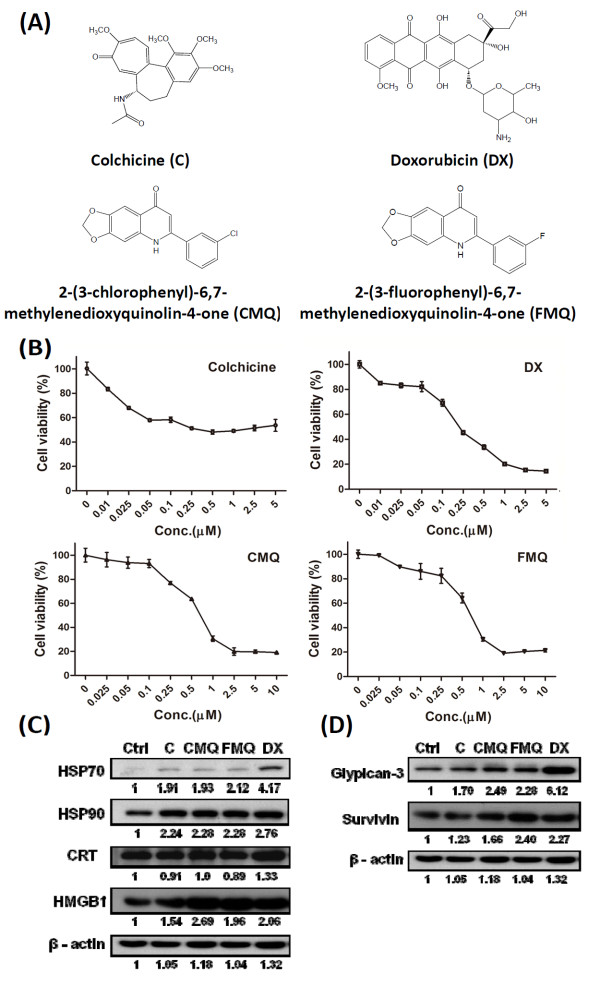
Expression of damage-associated molecular patterns (DAMPs) and tumor-associated antigens in tumor cell lysates of treated B16 melanoma. (A) The chemical structures of microtubule-depolymerizing agents and doxorubicin tested in this study are shown in A. (B) Effect of MDAs and doxorubicin on cell viability of B16 melanoma cells. Mouse B16 melanoma cells were treated with the indicated concentrations of colchicine, doxorubicin (DX), 2-(3-chlorophenyl)-6,7-methylenedioxyquinolin-4-one (CMQ) and 2-(3-fluorophenyl)-6,7-methylenedioxyquinolin-4-one (FMQ) for 24 h, as shown in B. The values are represented as the percentage of viable cells; the vehicle control group was regarded as 100% viable. Cell viability was determined by MTT assay and data were expressed as mean ± S.D. for triplicate culture samples. (C&D) Effect of MDAs and doxorubicin on expression of damage-associated molecular patterns (DAMPs) and tumor-associated antigens in treated B16 melanoma cells. B16 tumor cells were treated for 24 h with vehicle control, colchicine (C), CMQ, FMQ or DX, at a concentration of 2.5 μM. After treatment, TCLs were obtained through four freeze-thaw cycles. Western blot analysis for protein expression of damage-associated molecular patterns (DAMPs), heat shock protein 70 (HSP70), heat shock protein 90 (HSP90), calreticulin (CRT) and high-mobility group box-1 (HMGB1), is shown in C, and expression of tumor-associated antigens including glypican-3 and survivin, is shown in D. Expression of β-actin was used as an internal control. The results show one representative experiment of three independently performed experiments.